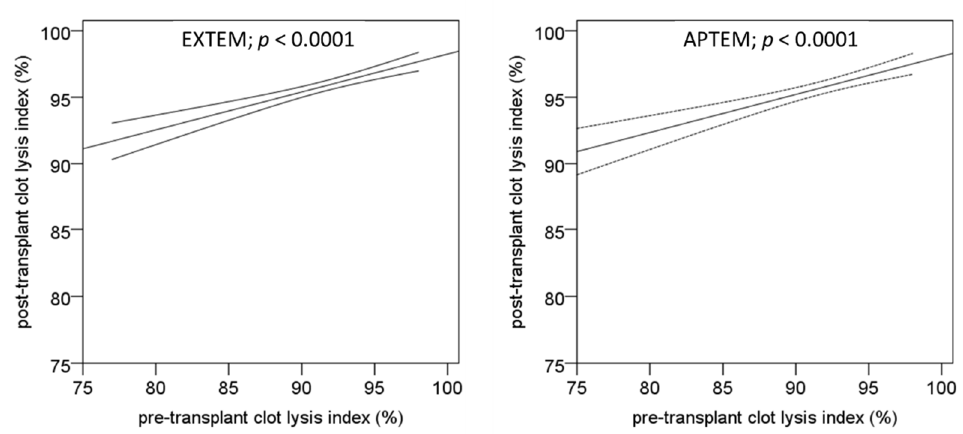
Figure 4. Linear correlation and confidence intervals (of the mean, 95%) of pre-transplant and post-transplant clot lysis index as obtained by rotational thromboelastometry. Whole blood samples were activated with tissue factor (EXTEM, left figure) and tissue factor combined with a fibrinolysis inhibitor (APTEM, right figure).